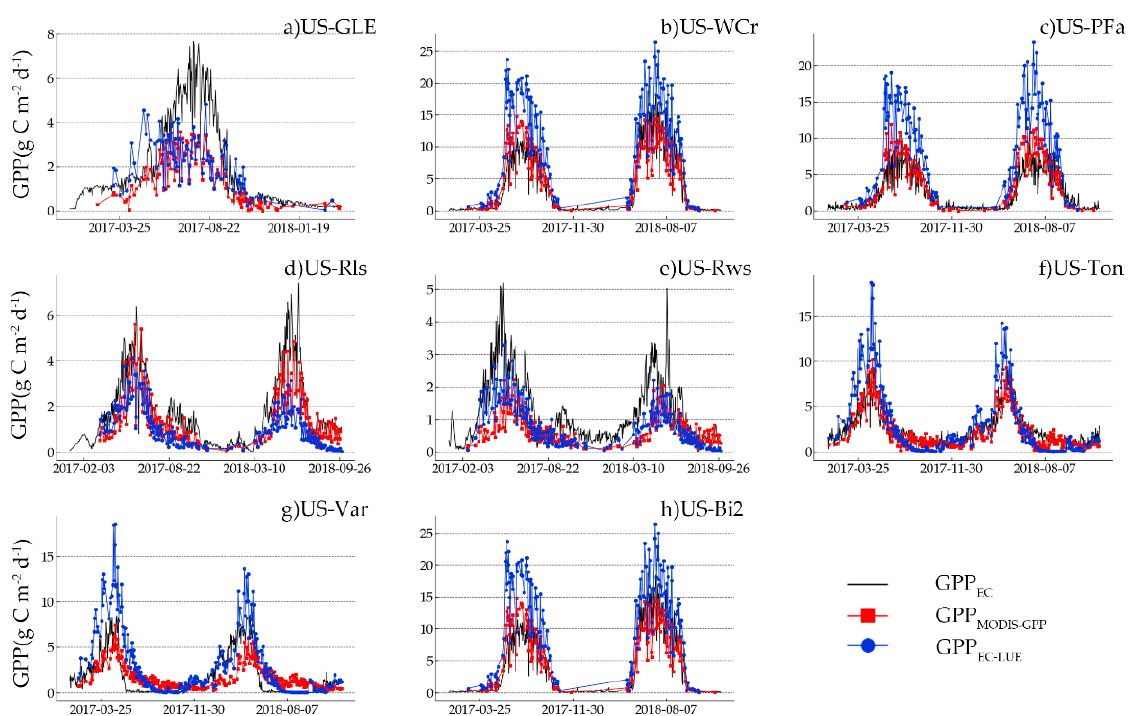
Figure 4. Temporal dynamics of GPP MODIS-GPP , GPP EC-LUE , and GPP EC for all sites in 2017–2018. ( a ): evergreen needleleaf forest site, ( b ) deciduous broadleaf forest site, ( c ) mixed forest site, ( d ) closed shrubland site, ( e ) open shrubland site, ( f ) woody savannas site, ( g ) grassland site, ( h ) cropland site.